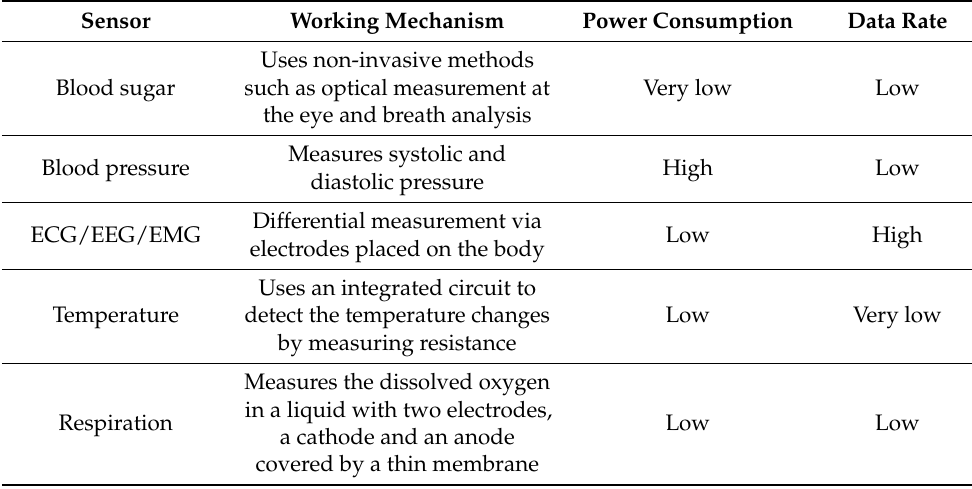
Table 6. Working mechanism of biosensors and their data rates in